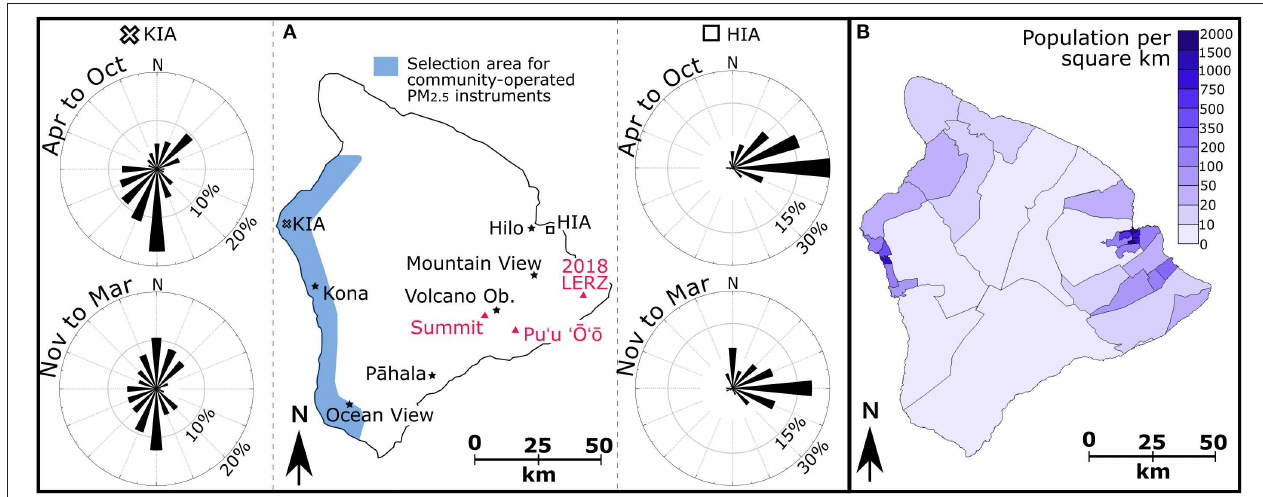
FIGURE 1 | Island of Hawai’i. (A) Ground-based sampling networks; HDOH and NPS stations indicated with black stars. K¯ılauea summit, Pu‘u ‘ ¯ O‘¯o vent and 2018 lower East Rift Zone eruption site indicated with red triangles. Selection area of community-operated PM 2.5 instruments indicated with blue highlight. Wind directions at Kona International Airport (KIA, empty black cross) and Hilo International Airport (HIA, empty black square) displayed as seasonal wind roses for period 2007–2018 ( NOAA, 2019). Note "Volcano Ob." stands for Volcano Observatory. (B) Population density per square kilometer on the Island of Hawai’i, based on 2010 Census data. Highest population density is located in the east-coast city of Hilo (population ~45,700) and the west-coast city of Kailua-Kona (population ~28,500) (Hawai’i Department of Business Economic Development and Tourism,